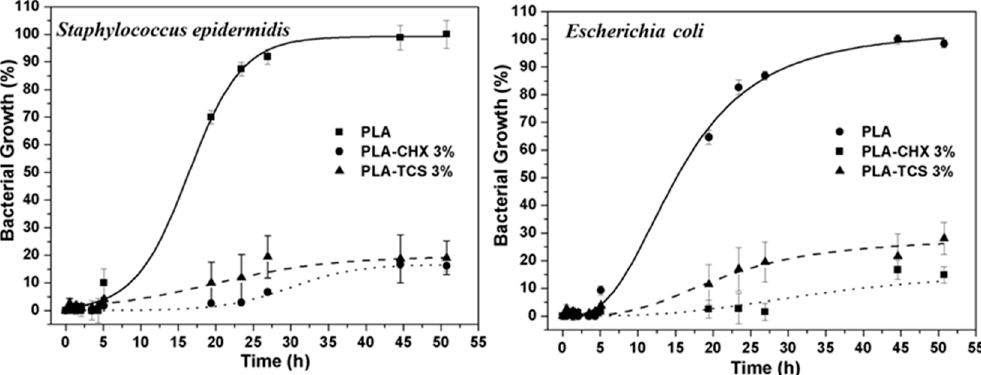
Figure 14. Staphylococcus epidermidis (left) and Escherichia coli (right) bacterial growth in presence of PLA samples and PLA loaded with 3 wt-% of TCS or CHX.